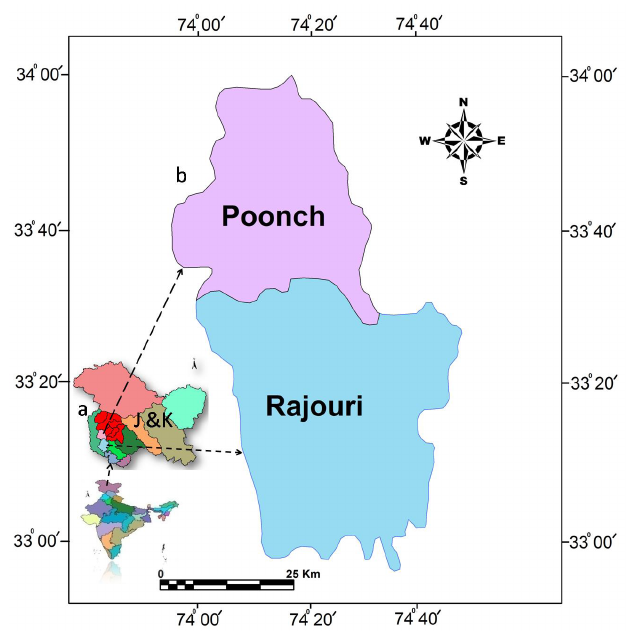
Location map of the study area: a) Jammu and Kashmir (J & K) State, India; b) Rajouri and Poonch